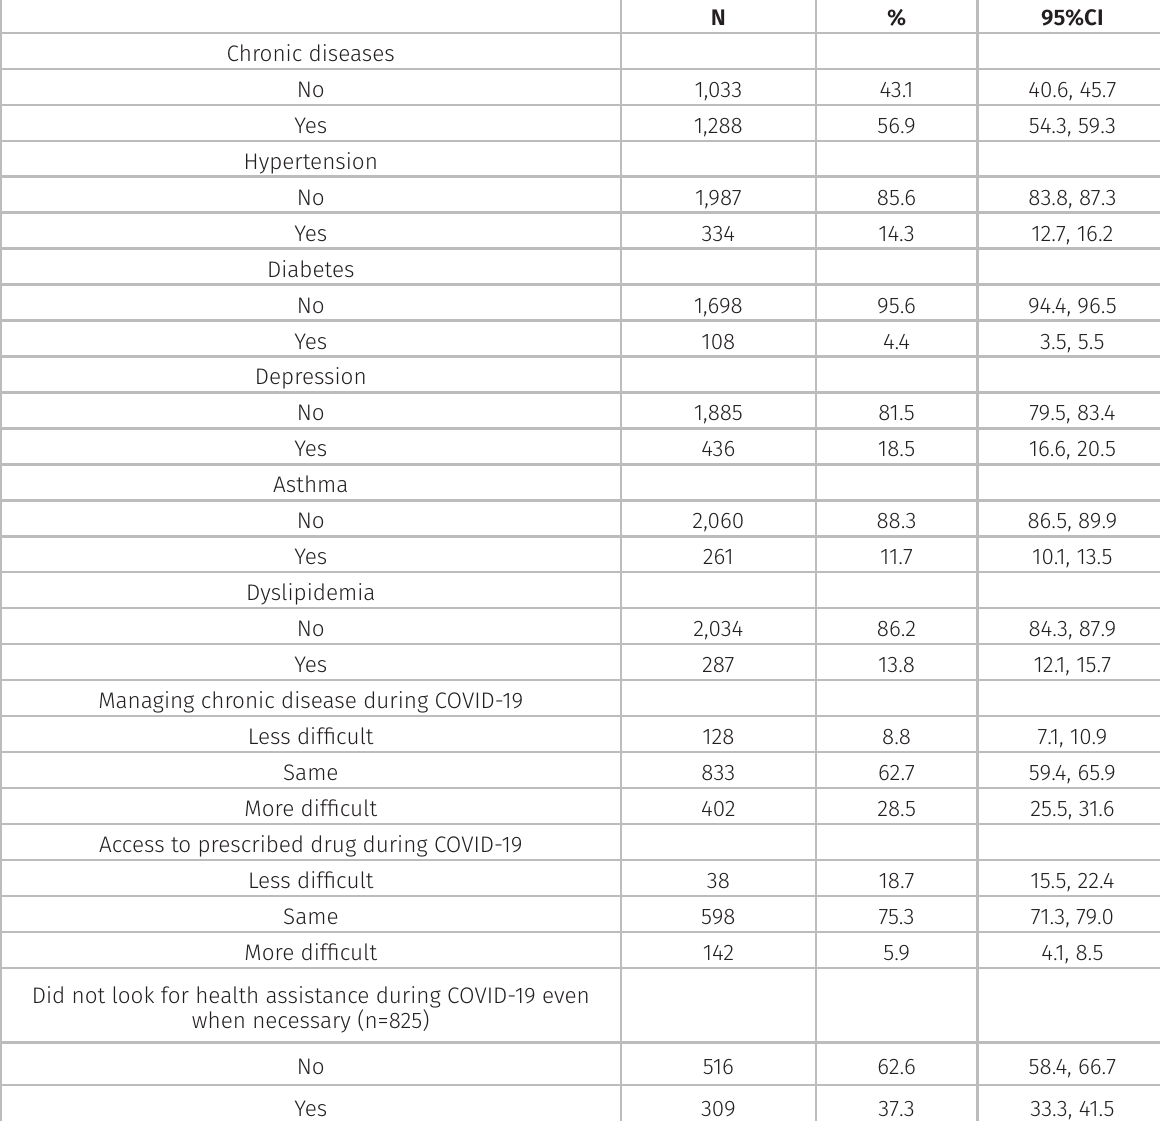
Table III. Prevalence of chronic diseases and access to treatment during COVID-19 pandemic in the included participants. Rio Grande do Sul, Brazil. N=2,321. CI: confidence interval. N %